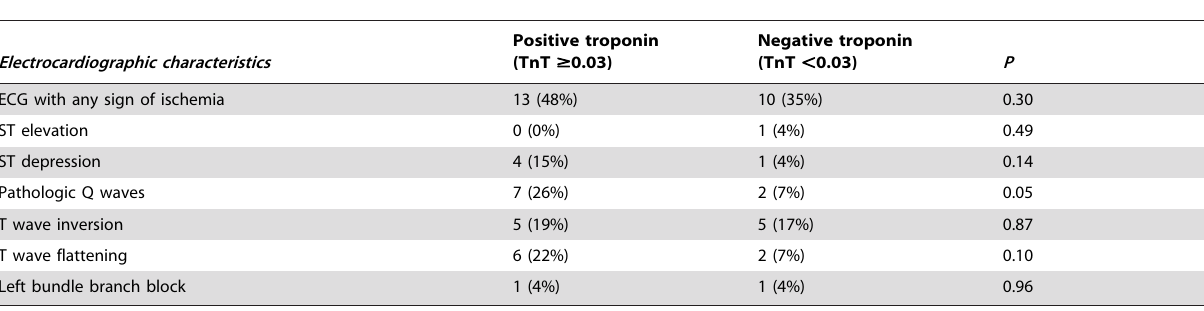
Table 6. Electrocardiogram characteristics, by cardiac marker status (n= 56). a